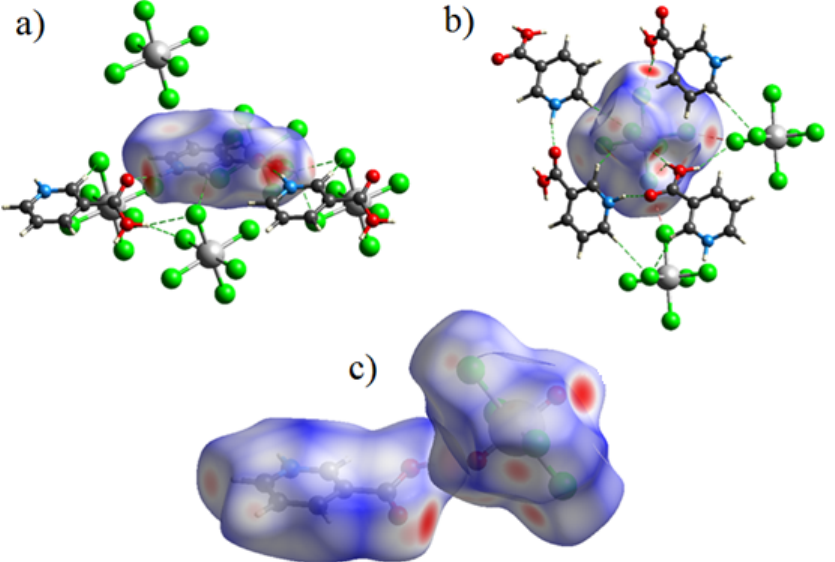
Figure 4. Hirshfeld surface mapper over d norm for ( a ) cation and ( b ) for anion to visualize the interactions in compound I and in II ( c ).